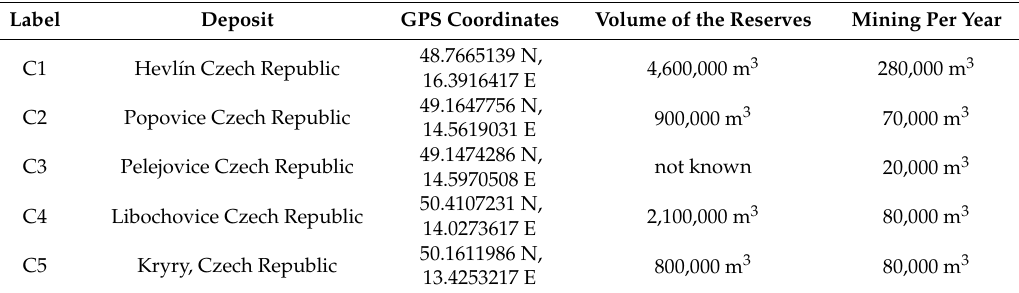
Table 1. Labeling of samples based on deposits locations.